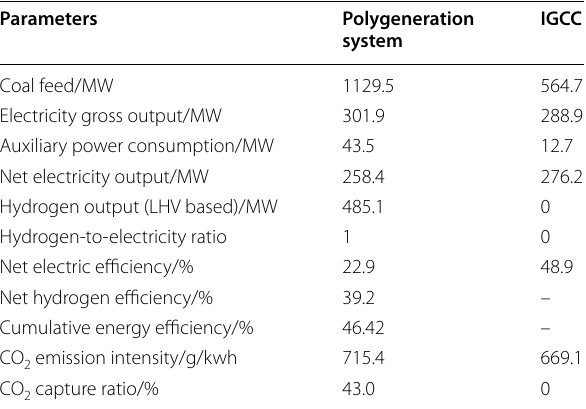
Table 5 Simulation results of the IGCC and polygeneration systems under the design conditions